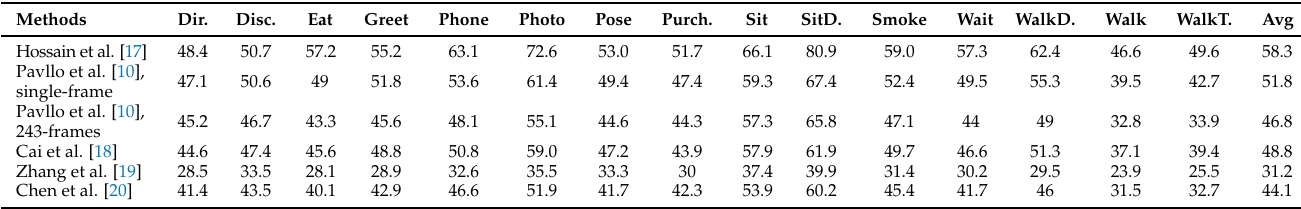
Table 2. Summary of performance on Human3.6 Protocol #1 (MPJPE: mm).